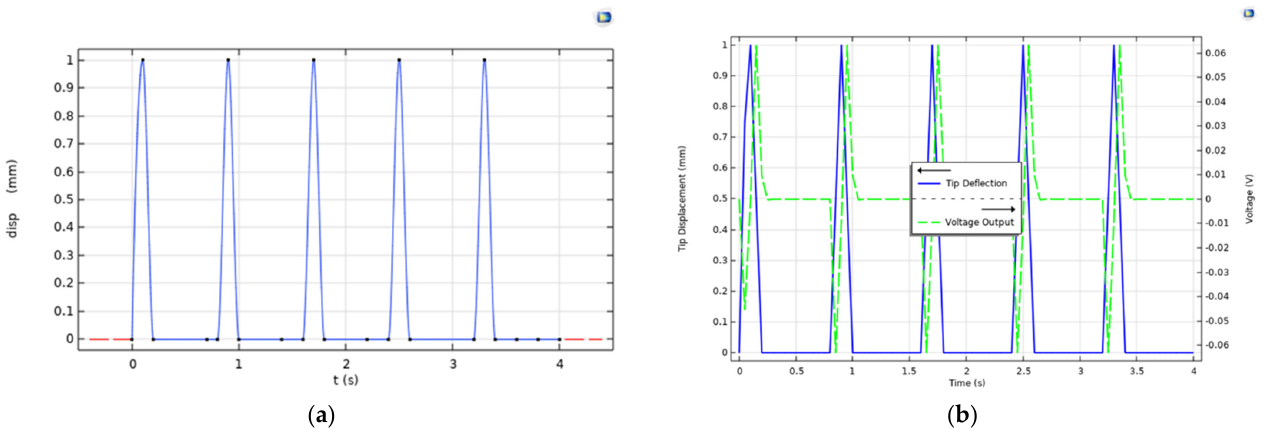
Figure 7. Preliminary finite element analysis. ( a ) Waveform of displacement applied to cantilever tip with a magnitude of 1 mm. Dashed red line indicates areas of no data points. ( b ) Cantilever tip displacement (solid-blue) and PEH voltage (dashed-green) as a function of time.